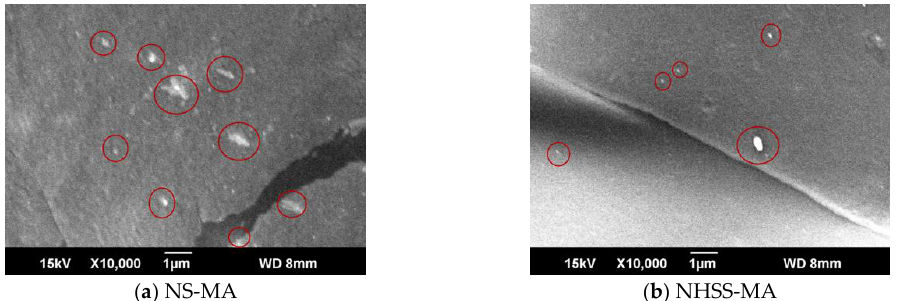
Figure 3. Scanning electron micrographs of nanosilica modified asphalt and NHSS modified